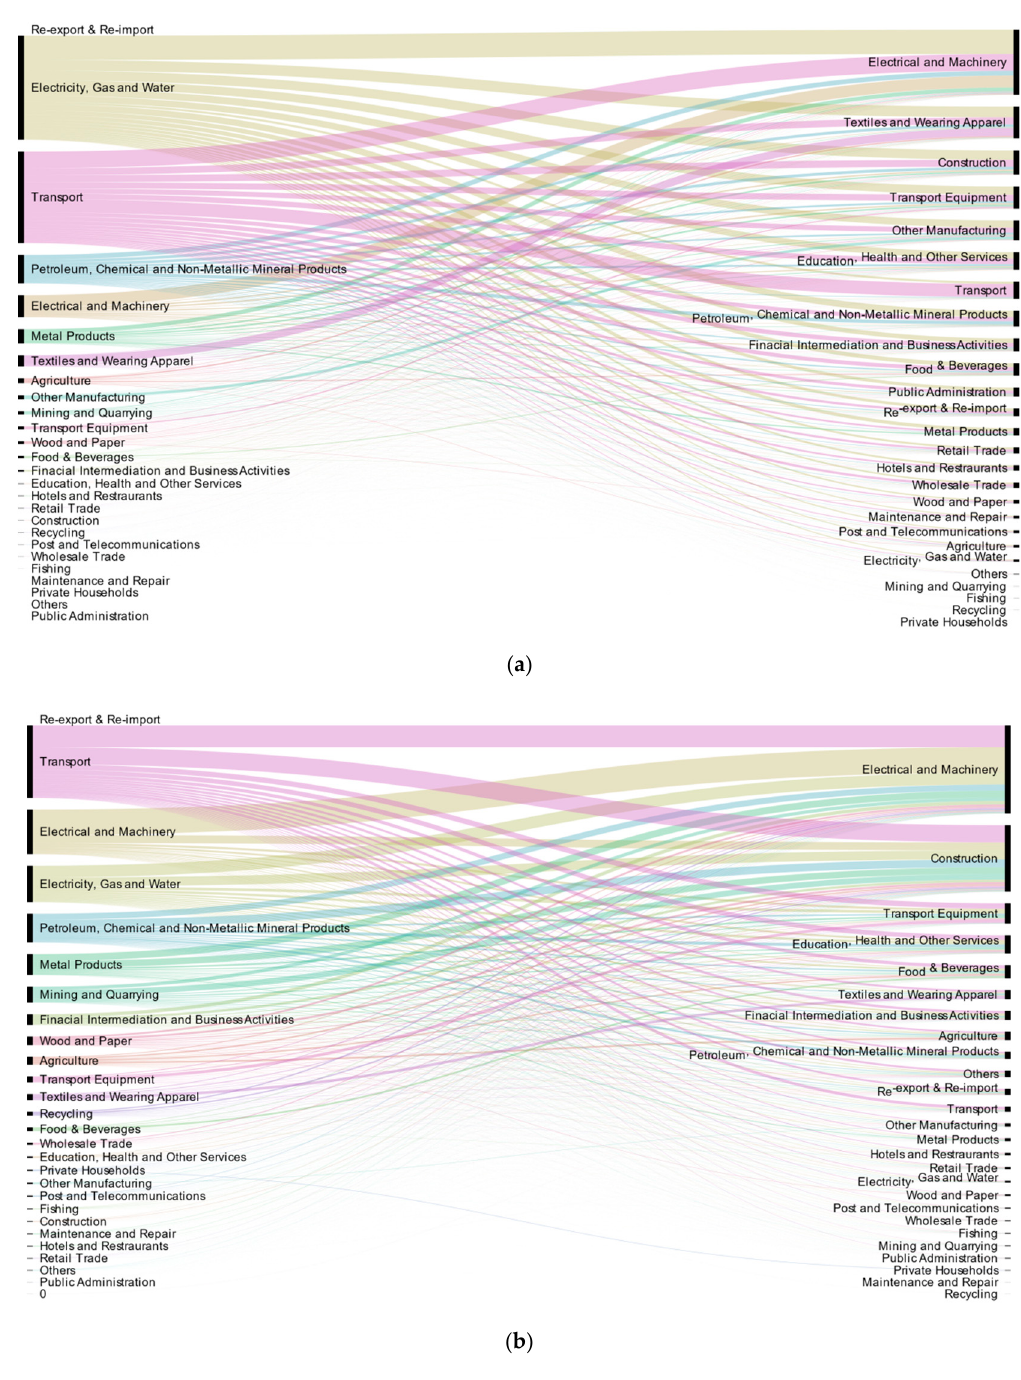
Figure 4. Industry transfer of the embodied NO x emissions in the bilateral trade between China and the EU in 2014. ( a ) Industry transfer of NO x emitted from China to the EU; ( b ) Industry transfer of NO x emitted from the EU to China. (The sender on the left and the receiver on the right).